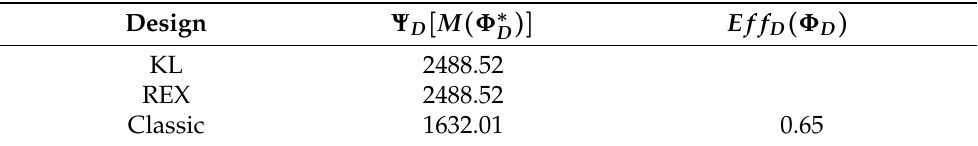
Figure 6. Support points of the D-optimal designs obtained by the adapted algorithms and the classic design. The values on the points obtained with the algorithms (7 and 4) are the number of replicas of each point. Table 2. Criterion